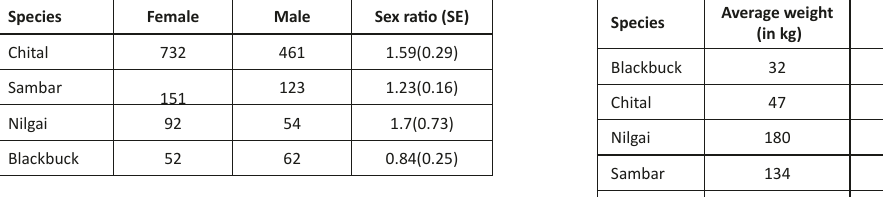
Table 2. Sex ratio of the ungulates species of VVNP, Bhopal. Species